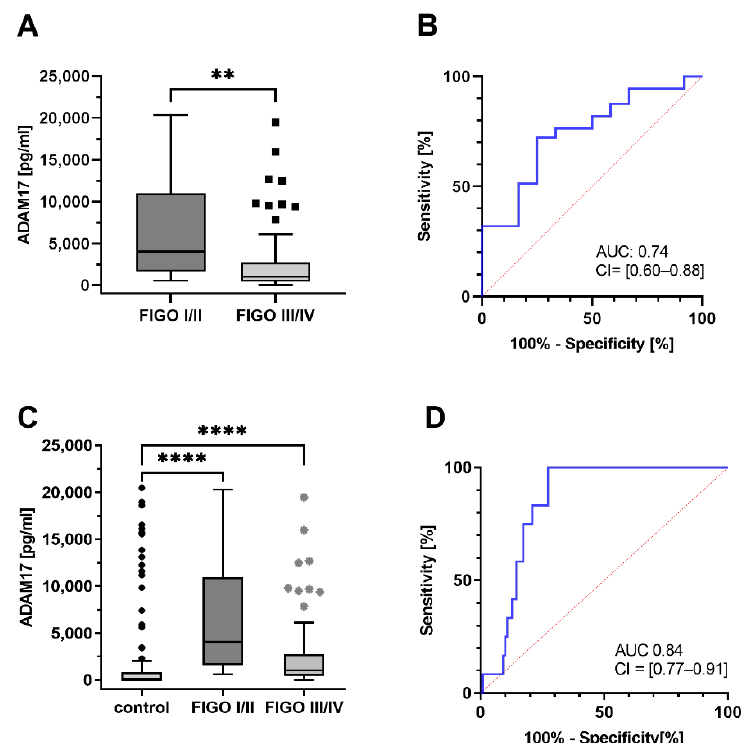
Figure 4. ( A ): Higher concentrations of ADAM17 in early FIGO stages. There is a significant difference between FIGO I/II and FIGO III/IV regarding the ADAM17 levels ( U -test, p = 0.007) ** ( p < 0.01). ( B ): Receiver operating characteristic: A cut-off value of 2588.5 pg/mL was calculated by ROC analysis. This corresponds to a sensitivity of 72.22% and specificity of 75.00% with an AUC of 0.74 (CI = [0.60–0.88]) predicting tumor stage in ovarian cancer at the preoperative point in time. ( C ): Comparison between healthy cohort, FIGO I/II and FIGO III/IV ( U -test, p < 0.0001) **** ( p < 0.001). ( D ): Receiver operating characteristic: AUC 0.84 (CI = [0.77–0.91]).